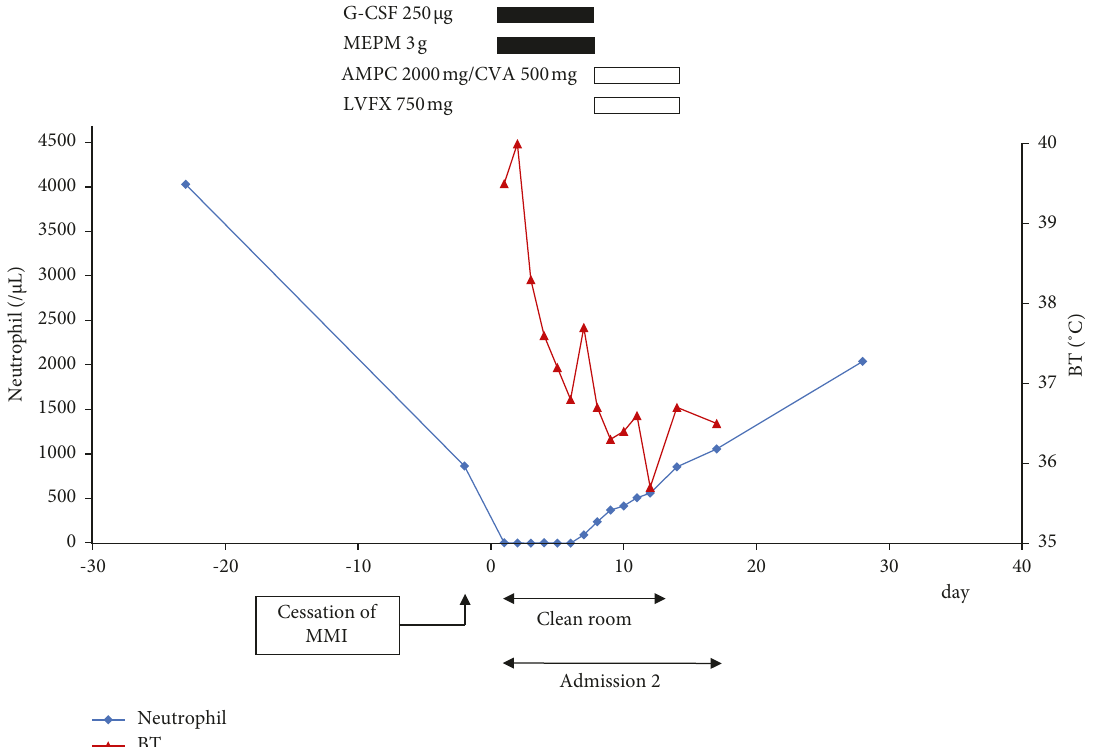
Figure 4: Clinical course of the patient during the second admission due to febrile neutropenia. G-CSF: granulocyte colony-stimulating factor; MEPM: meropenem; AMPC: amoxicillin; CVA: clavulanate; LVFX: levofloxacin; and BT: body